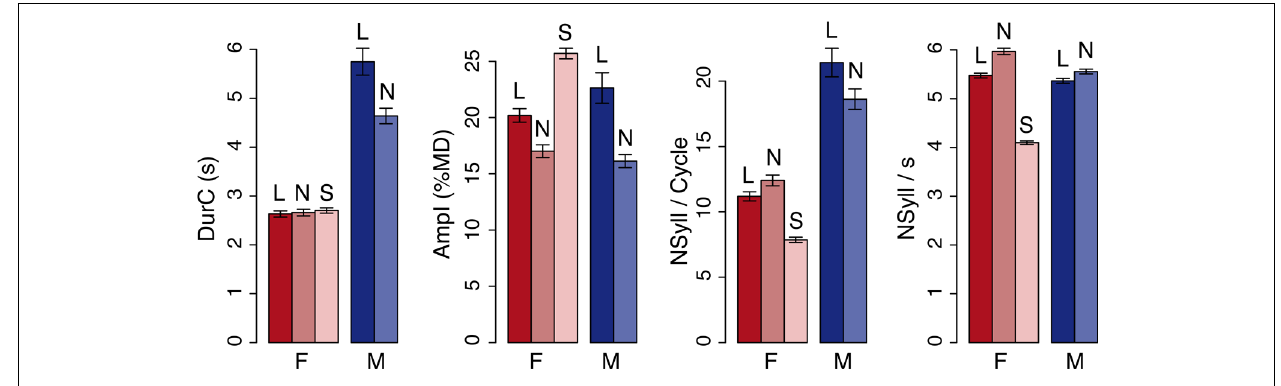
FIGURE 2 | Readers’ behavior. From left to right: duration of the breathing cycle, amplitude of inhalation, number of syllables, and syllable rate of the breathing cycle. The values are means and standard errors for all observations. Data are plotted separately for the female (F) and